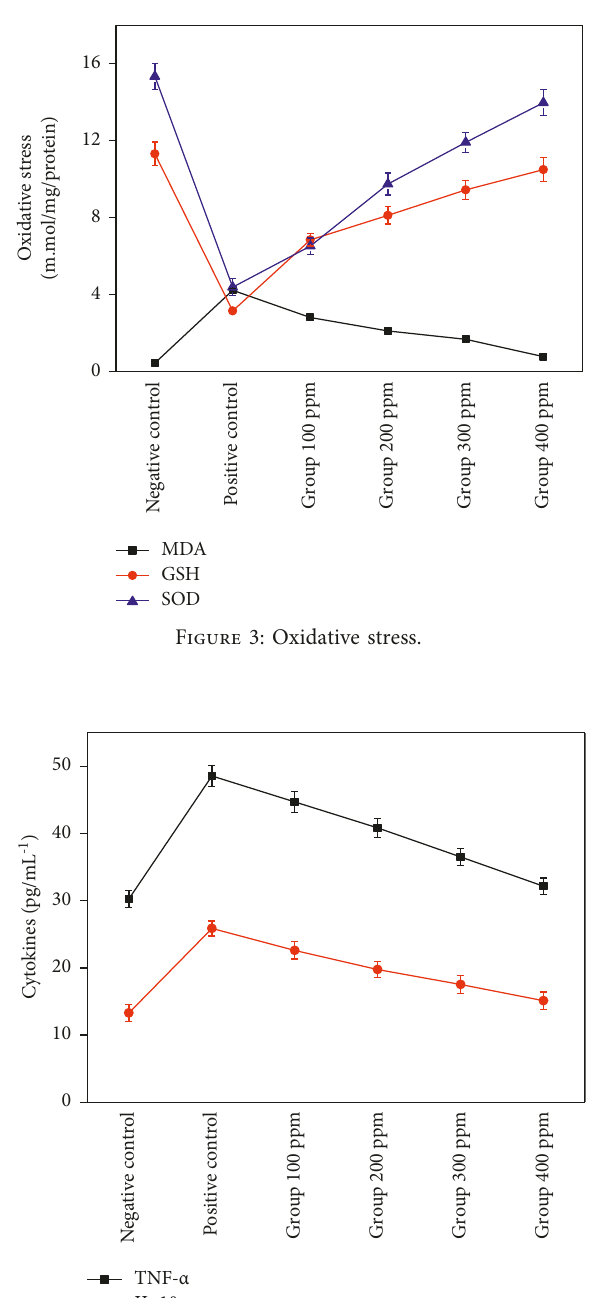
Figure 4: Cytokines IL-10 and TNF- α